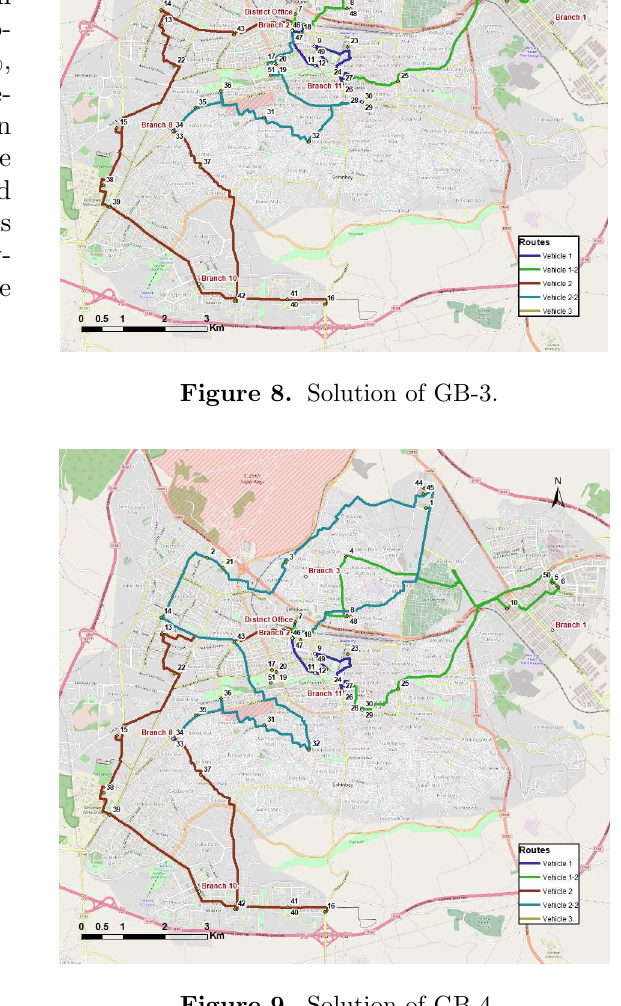
Figure 9. Solution of GB-4.